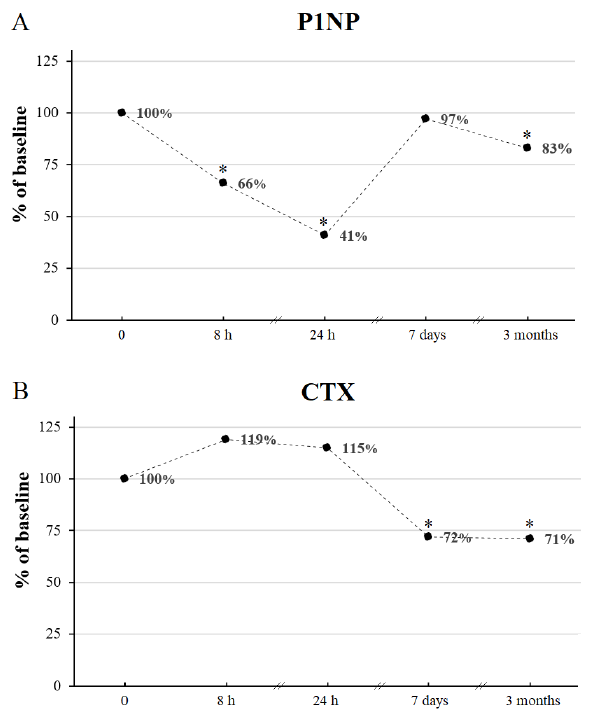
Figure 3. The percentage changes of P1NP ( A ) and CTX ( B ) during IVMP therapy with respect to the corresponding baseline values (0). * p value < 0.05 vs. corresponding time point before IVMP therapy. CTX, C-terminal telopeptide of type I collagen; h, hours IVMP, intravenous methylprednisolone; P1NP, amino-terminal propeptide of type I procollagen. 3.3. The Influence of the Full Course of IVMP Pulse Therapy on BTM and Calcium Metabolism Parameters P1NP and CTX decreased significantly after the full course of IVMP treatment reach- ing 83% and 71% of the baseline value, respectively (Figures 3 and 4, Table 2). We found a positive correlation between P1NP and CTX after 12 weeks ( r = 0.91, p value < 0.001). No change of 25(OH)D or iPTH was noticed after IVMP therapy.